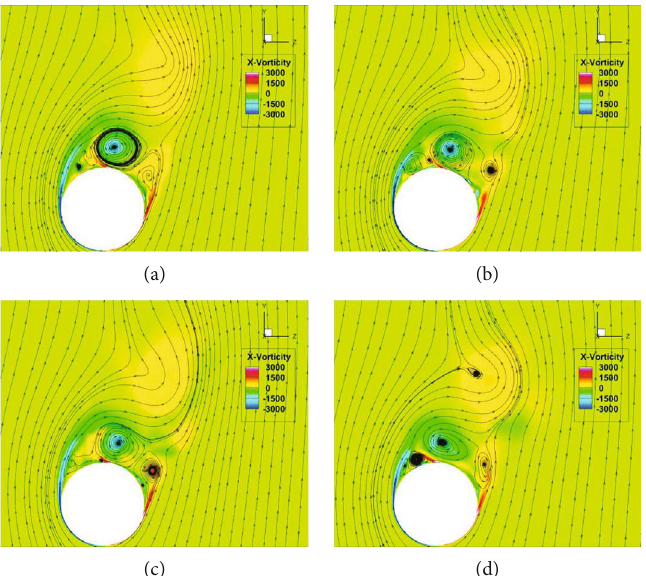
Figure 21: Contrast contour of X -vorticity with di ff erent roughness values at section 4: (a) Model 1, (b) Model 2, (c) Model 3, and (d) Model 4.